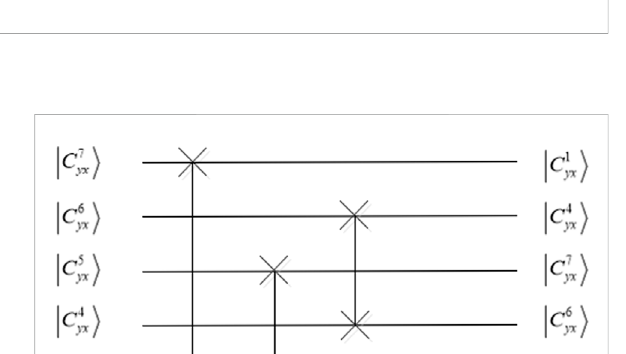
FIGURE 10 Flowchart of image encryption algorithm.